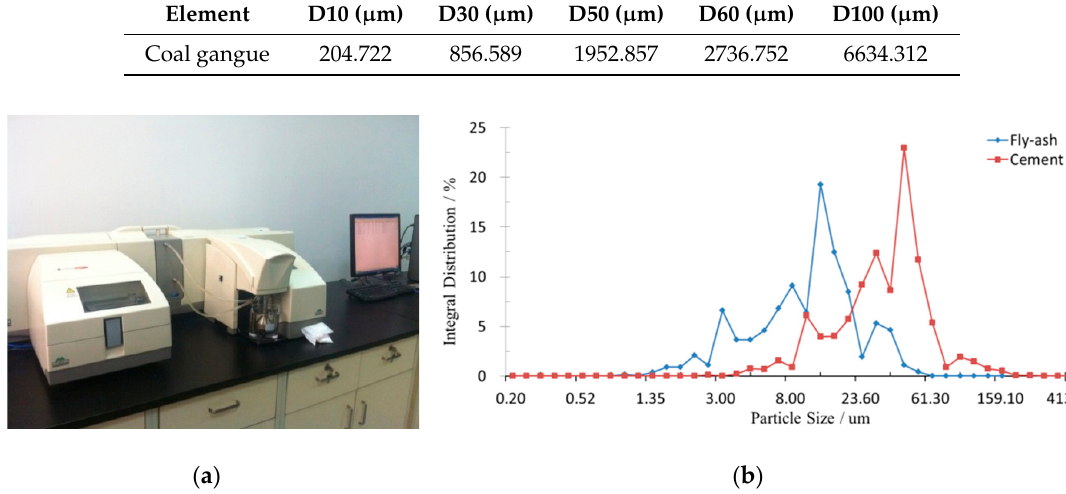
Table 1. Particle size composition of the coal gangue use in the coal gangue-fly ash backfill (CGFB) slurry.